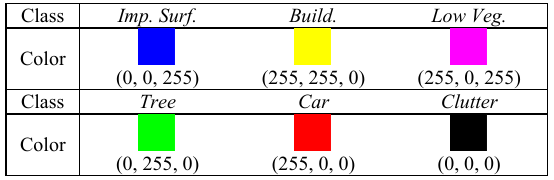
Table 5. The land cover classes and the corresponding colors on labels of the ISPRS Vaihingen dataset.